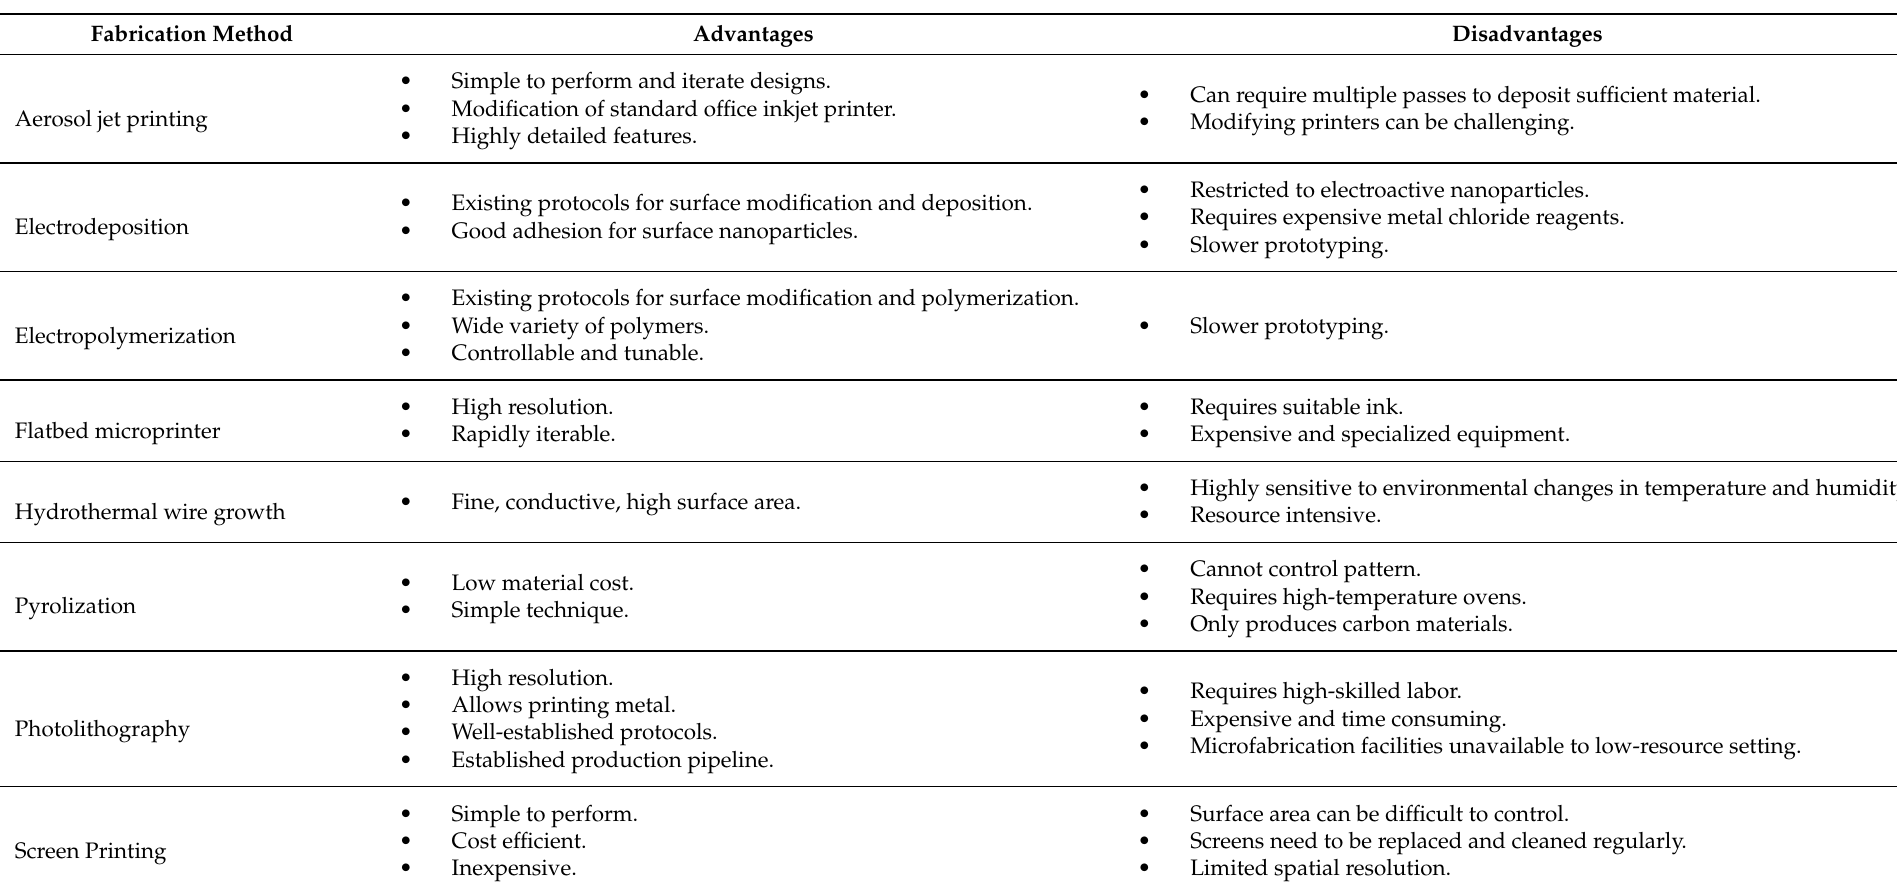
Table 1. A summary of different fabrication